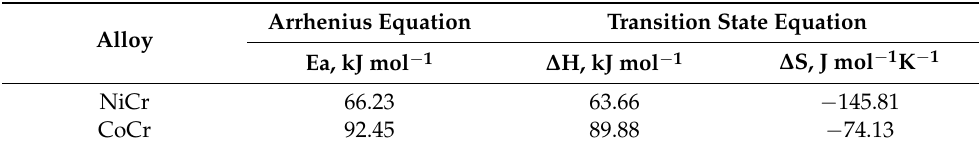
Figure 7. Arrhenius plots in artificial saliva for the two studied alloys. Table 3. Kinetic corrosion parameters obtained from the Arrhenius equation and the transition state equation for NiCr and CoCr alloys at different temperatures of artificial